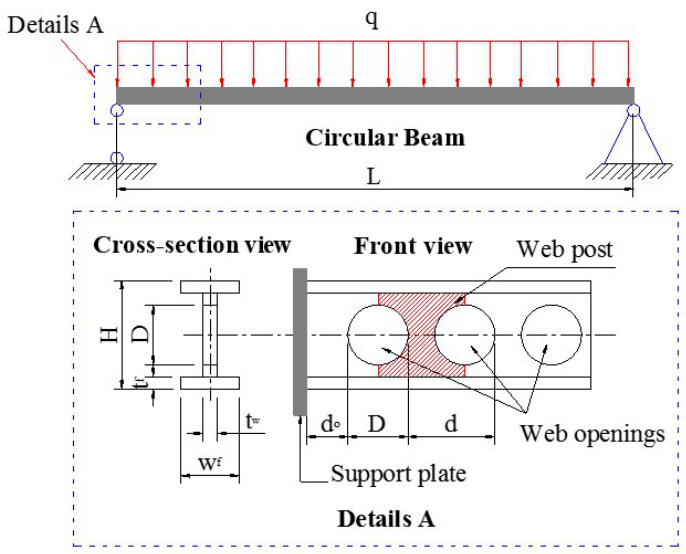
Figure 1. Diagram of circular opening steel beam under uniform loading and its geometrical parameters. Table 1. Initial statistical analysis of the dataset.